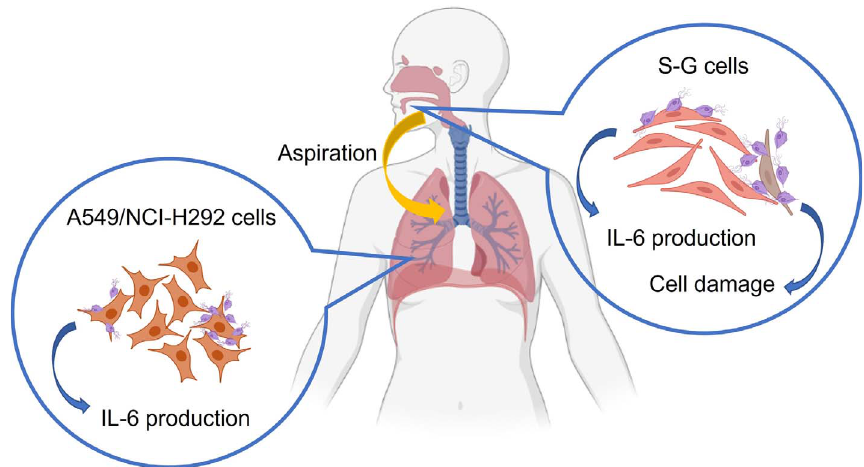
Figure 4. The overall effect of pathology and immune response that Trichomonas tenax induced on gum S-G cells and alveolar A549 cells. S- G cells was damaged at high MOI, while the production of IL-6 was induced at low MOI. A549 cells induced IL-6 at both low and high MOI. The fi gure was created with